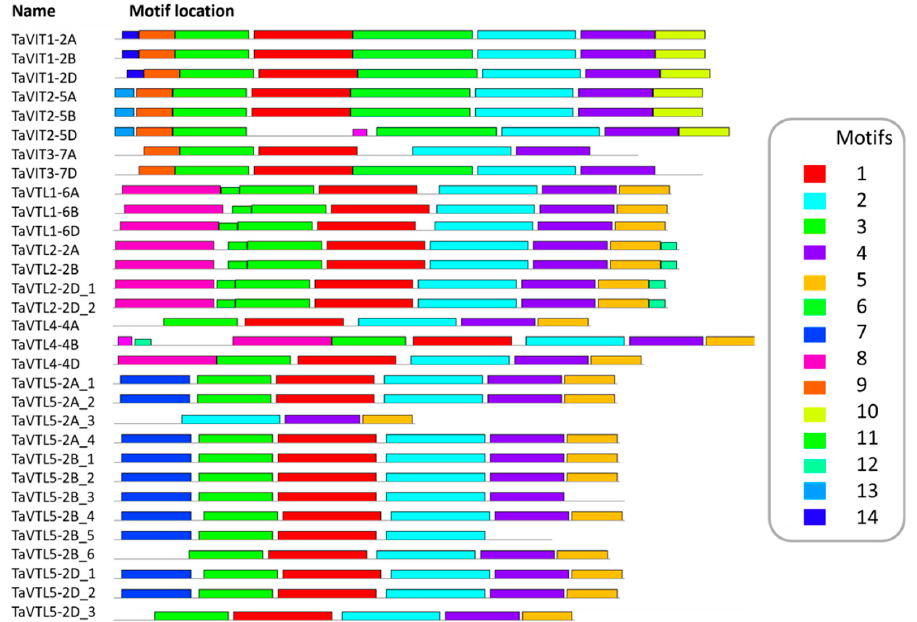
Figure 3. Conserved motifs identified for TaVIT and TaVTL proteins using MEME suite 5.1.0. The colored rectangles on each sequence represent specific conserved motifs numbered 1 through 14, as depicted by the color codes in the box.